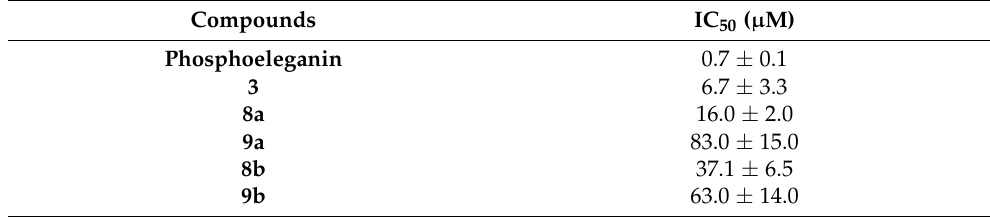
Table 1. IC 50 values determined on